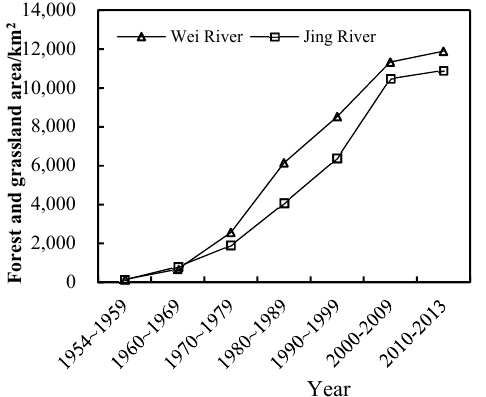
Figure 14. The area of forest and grassland implemented in Wei and Jing River basins during 1954–2013.